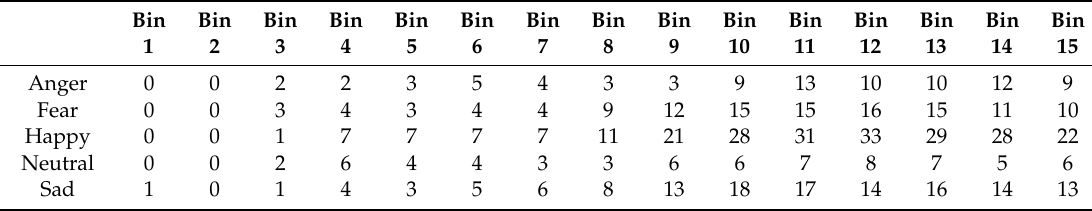
Table A4. Number of infants with ≥ 1 mouth fixations per